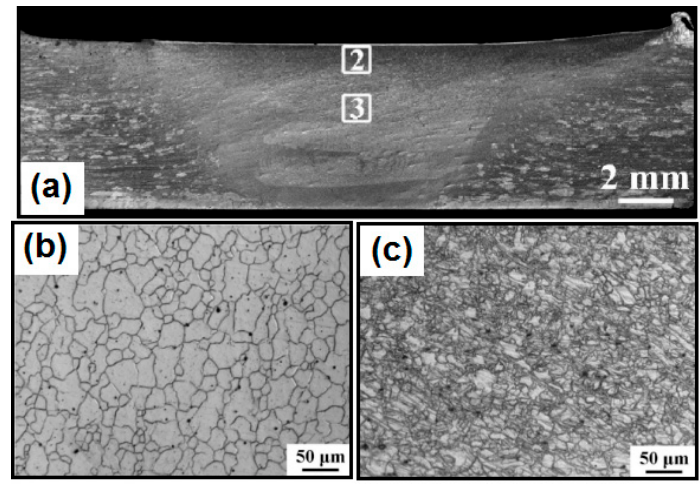
Figure 6. Macro- and microstructure of single-pass FSPed AZ31 alloy (reproduced from [129], with permission from Elsevier, 2019): ( a ) specimen macrostructure in the region processed at 200 rpm; ( b ) base alloy microstructure; ( c ) stir zone microstructure (2). Table 4. Experimental data on FSP of magnesium alloys.